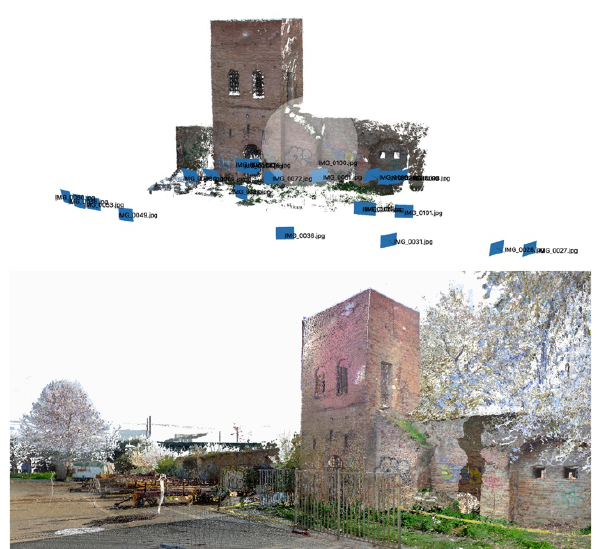
Figure 12. Above, one of the work chuncks obtained by photomodeling, below a partial view of the point cloud obtained by laser